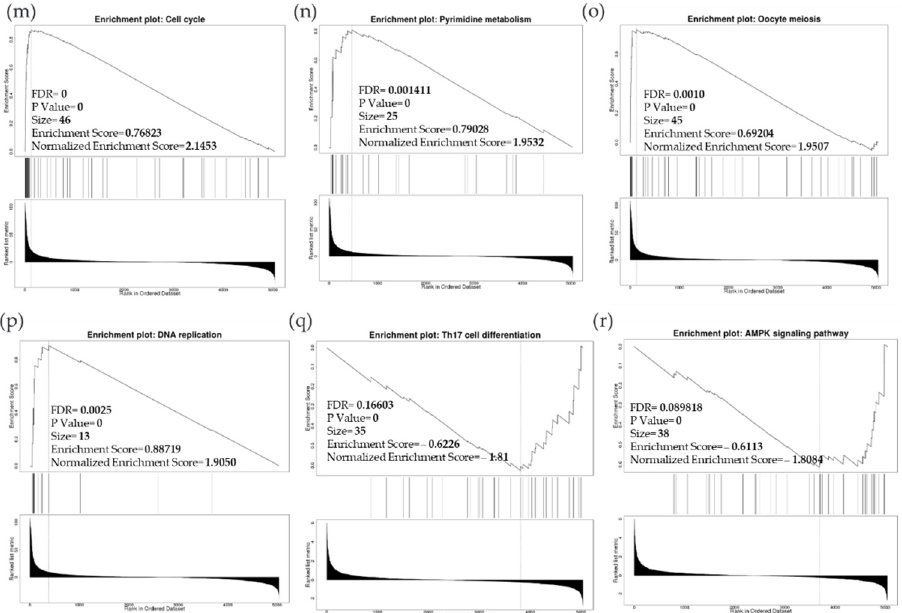
Figure 11. BIRC5 pathway enrichment, target gene expression, and target gene ontology. ( a ) Volcano plots of the genes with BIRC5 expression that are negatively and positively correlated. Genes that were negatively associated with BIRC5 expression are represented by the green section of the volcano curve, whereas positively correlated genes are shown by the red section of the curve (accessed on LinkedOmics:: Volcano Plot). GSEA GO ( b ) genes that co-express BIRC5 in a biological process. Blue bars show pathways that are highly enriched in positively linked genes, with dark blue bars denoting pathways with FDR < 0.05 and light blue bars representing pathways with FDR > 0.05. Orange bars show routes that are more likely to contain genes that are inversely correlated, with light orange bars showing pathways with FDR > 0.05. Inversely associated genes were overrepresented in the topmost significant pathways, as demonstrated by the enrichment plots in ( c – k ). ( g ) GSEA KEGG for BIRC5 and co-expressed genes KEGG database enrichment plots. ( l – r ) show the topmost significant pathways that are over-represented among negatively correlated genes, www.linkedomics.org/lo_batchfile/qindex_gsea.php?fn=120514 (accessed on 5 August 2022).